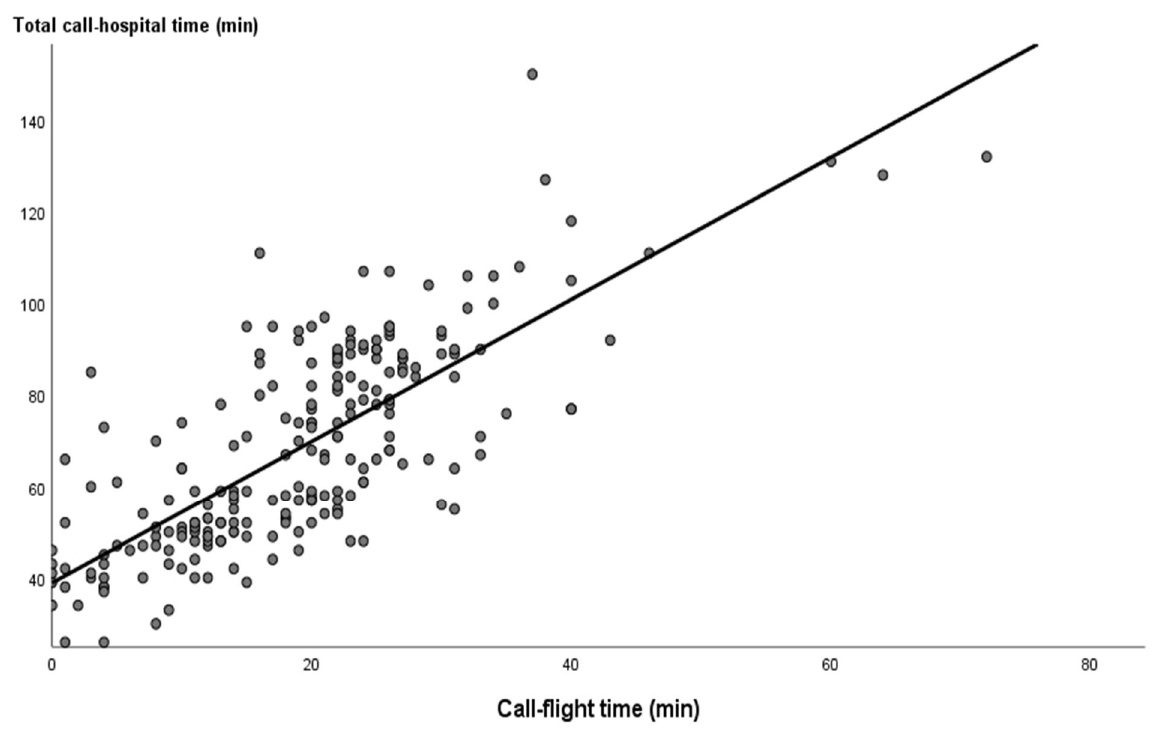
Figure 3. A regression plot with the equation of linear regression demonstrated a correlation be- tween the total time from call to hospital and call to fl ight time, y = 1.55X + 38.89, r = 0.761, P <